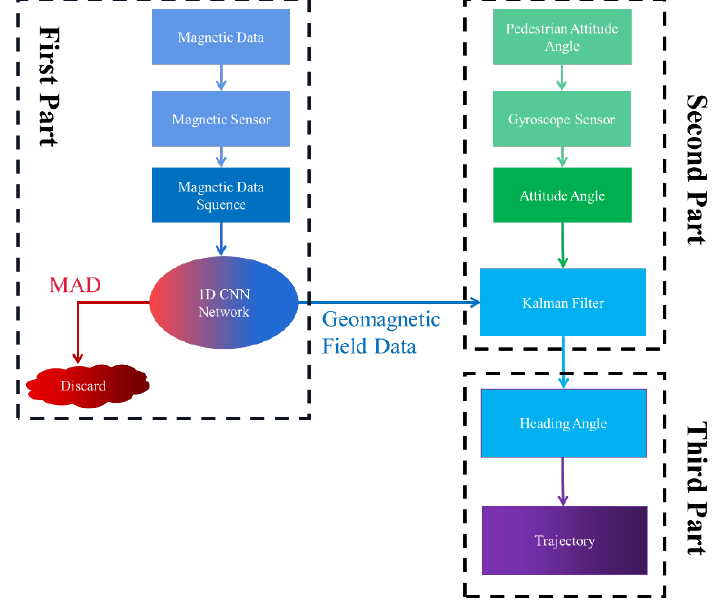
Figure 3. The flowchart of the heading angle calculation based on a one-dimensional convolutional neural network (1D CNN).